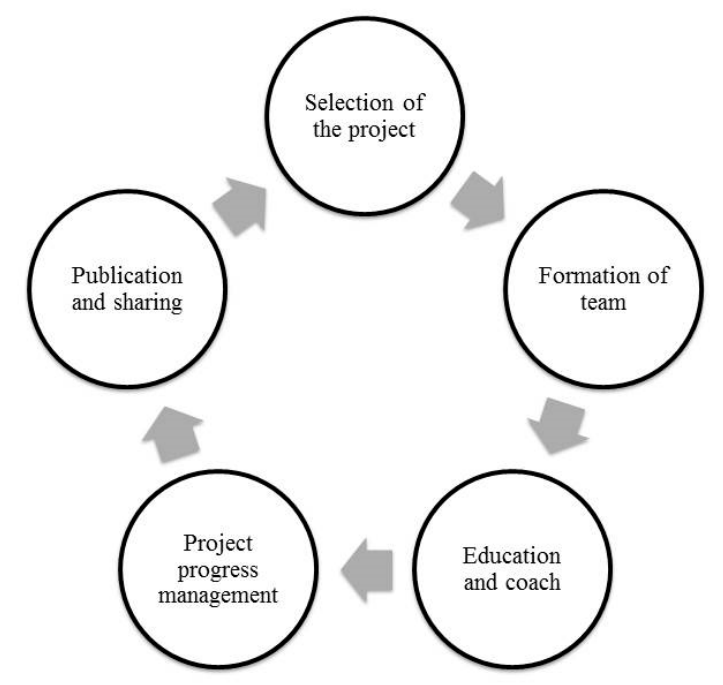
Figure 1. Annual activity plan of quality control circles program (QCCP).